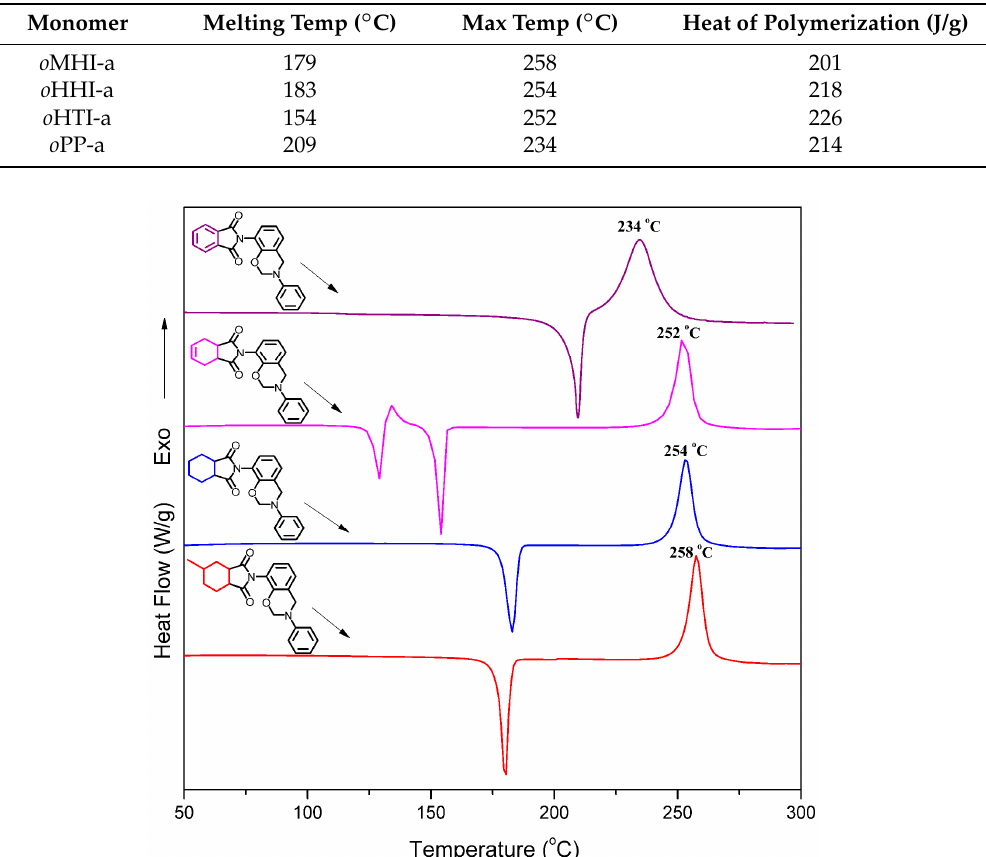
Figure 5. DSC thermograms of ortho -imide functional benzoxazine monomers.